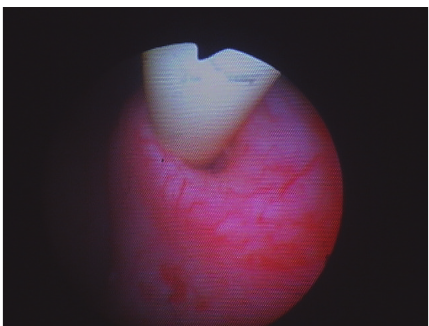
Figure 3: Foley balloon residing in proximal ureter, visualized through flexible ureteroscope.